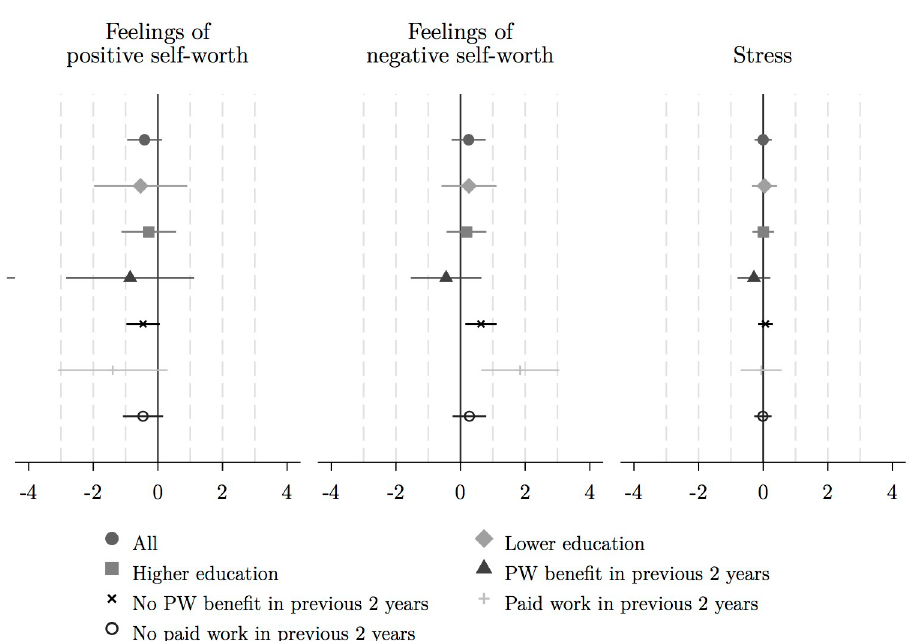
Fig 3. OLS estimation results, full sample and by subgroups: Positive and negative feelings of self-worth and stress. Source : Author’s own calculations. The markers indicate the point estimates and the extending lines the 90-per cent confidence intervals. In all models, control variables are included. The graph is created in Stata with the coefplot command developed by Jann [98].